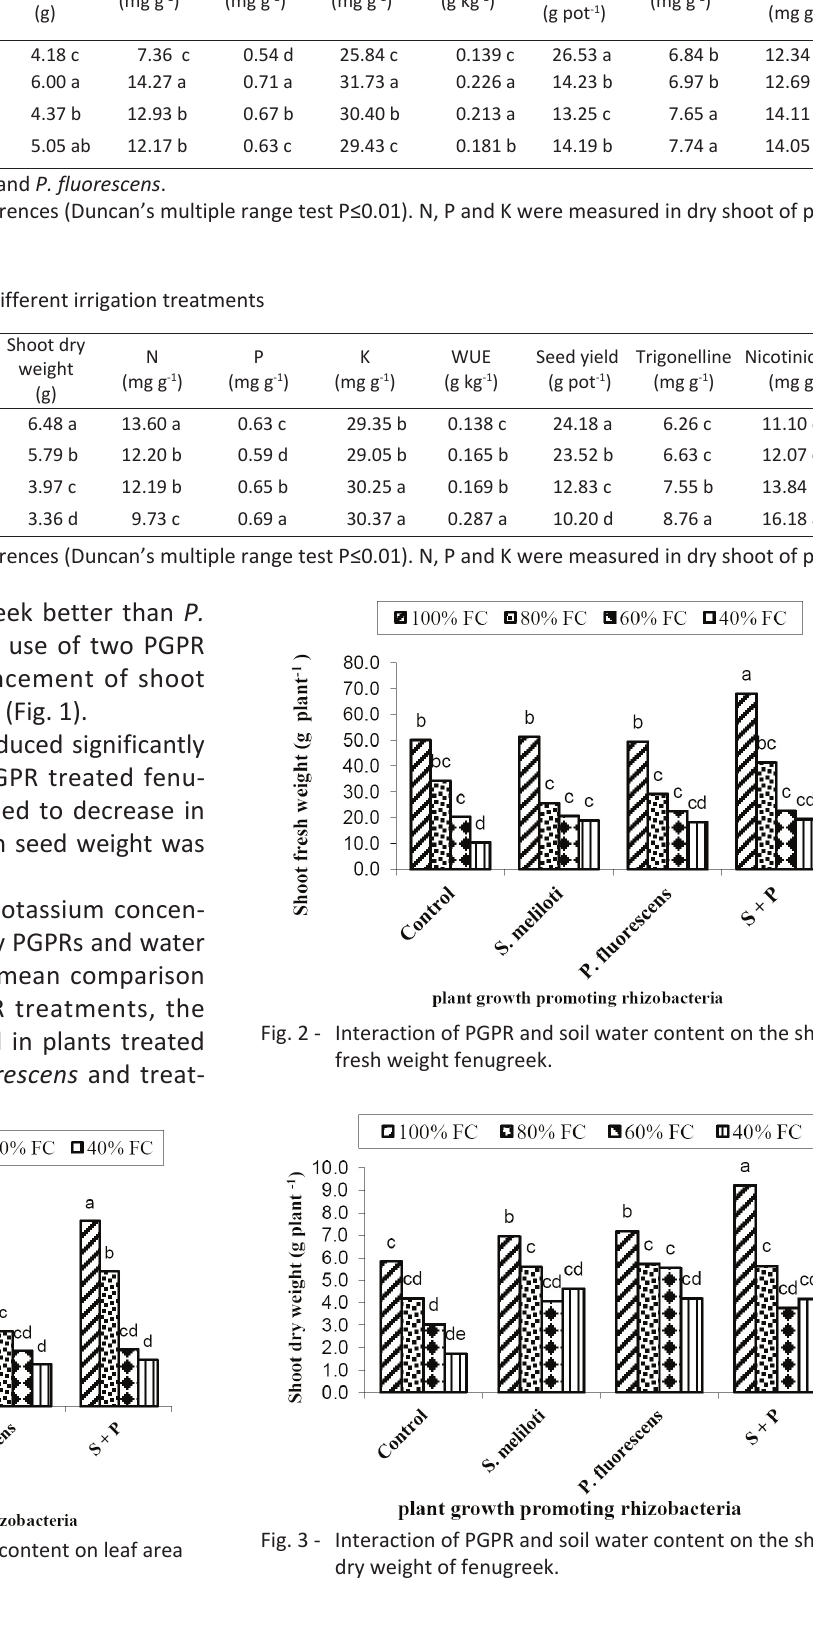
Table 1 - Results of mean comparison of different PGPR treatments